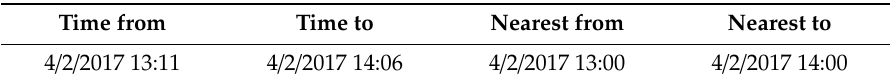
Table 3. Timestamp adjustment rounded to the nearest hour. Time from Time to Nearest from Nearest to